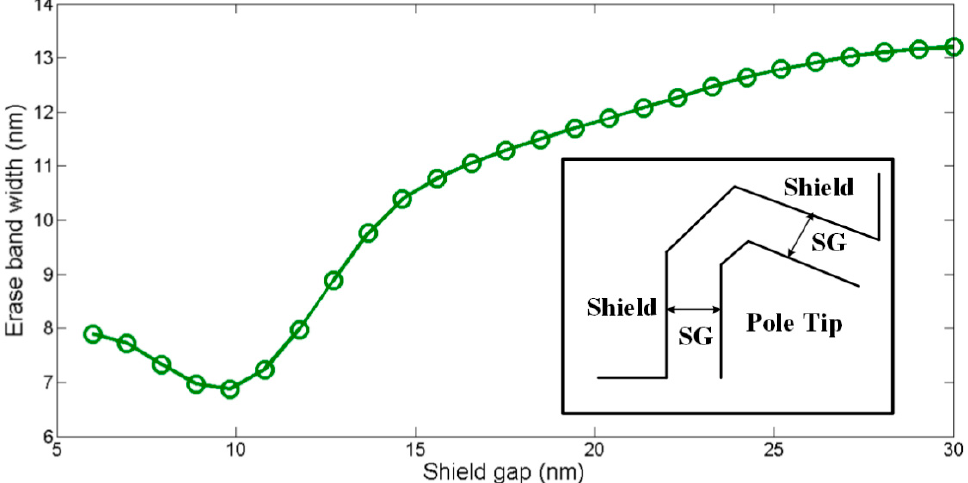
Figure 8. Erase band width versus shield gap ( SG ). Inset: The SG is the distance between pole tip and shield.